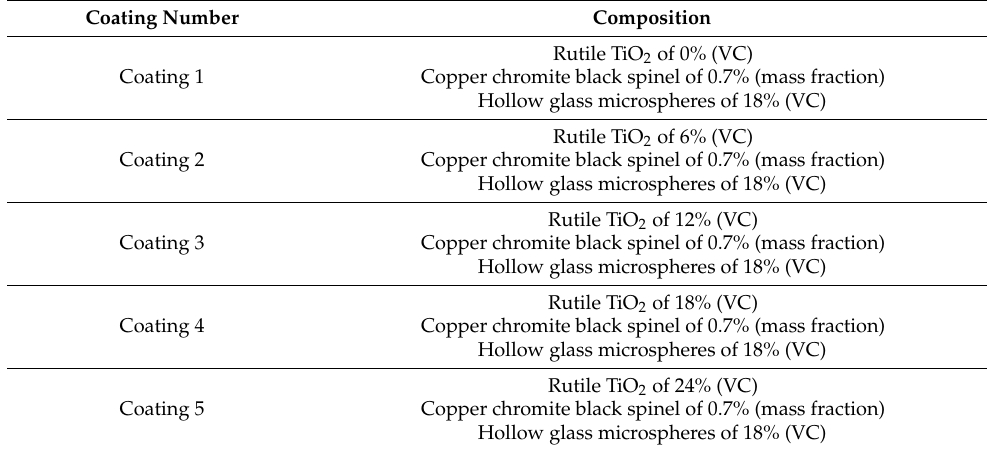
Table 5. CCCLs containing different contents of rutile TiO 2 .